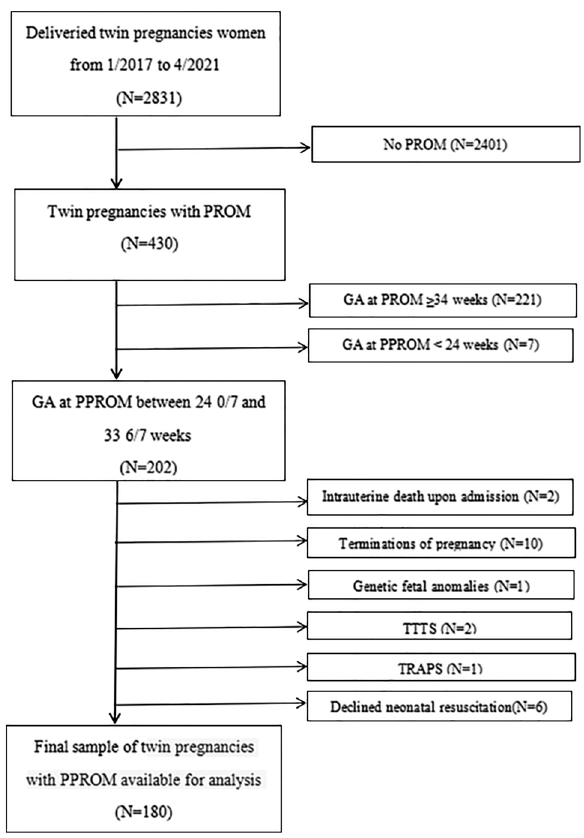
Figure 1. Flow chart of the study population. Legend: GA gestational age, PROM premature rupture of membranes, PPROM preterm premature rupture of